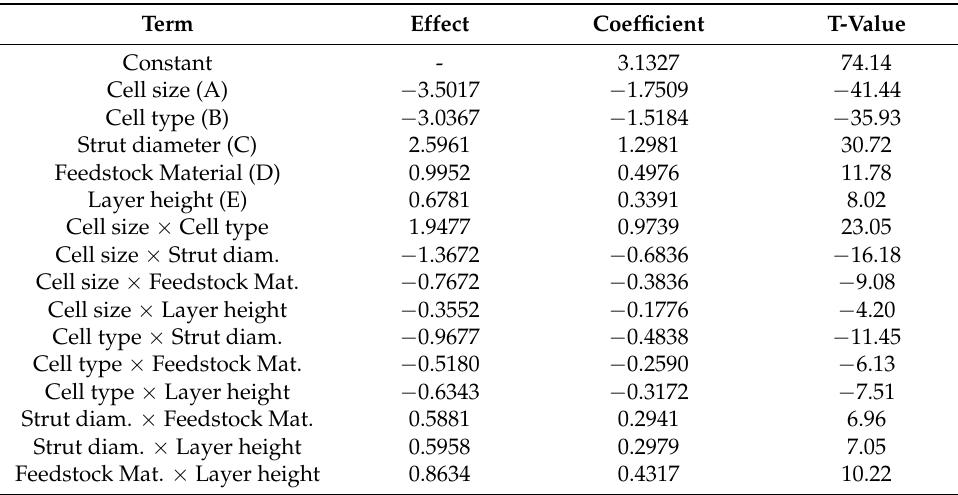
Figure 7. Main effect plots for elastic modulus, E. Table 6. Regression coefficients for plateau